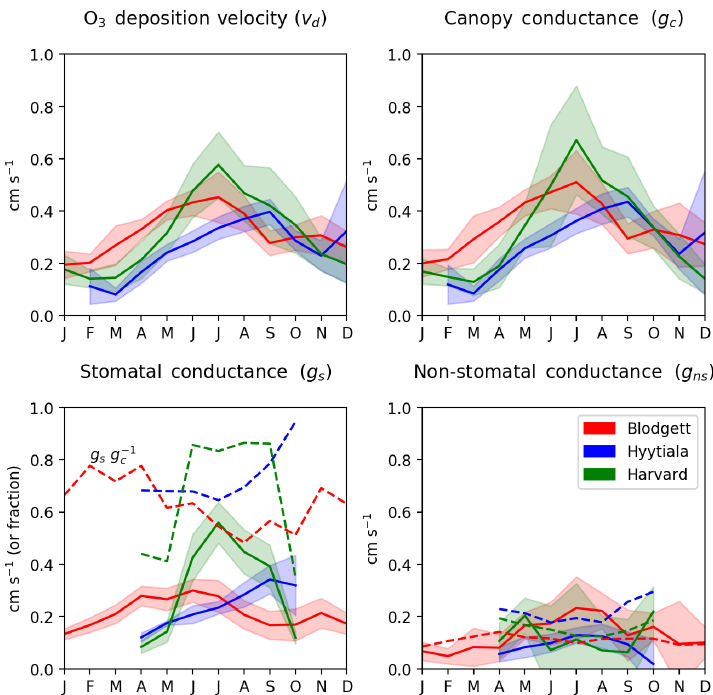
Figure 5. Observed O 3 deposition velocity and its in-canopy components at sites with O 3 flux measurements. Lines show the multi-year mean and multi-year standard deviation calculated from the monthly averages described in Sect. 2.4. Dashed lines in the stomatal conductance panel show the stomatal fraction of total canopy conductance ( g s g − 1 c ) and dashed lines in the non-stomatal conductance panel show the parameterized g ns